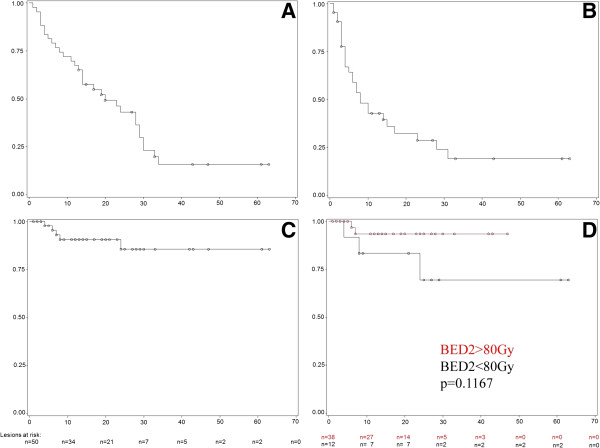
Kaplan-Meier-plots for overall survival, progression free survival and local control. A: Overall Survival of all patients, B: Progression Free Survival of all patients, C: Local Control of all lesions, D: Local Control for lesions treated with a BED2 > 80 Gy (red) and a BED2 < 80 Gy (black). The p-value shows a trend for a better local control with higher BED2. N: Number of lesions at risk at every given time-point.